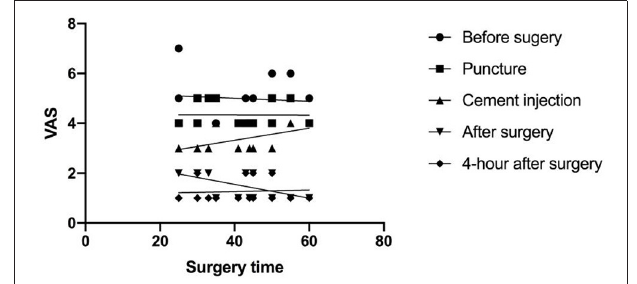
FIGURE 1 | The correlation of the visual analog scale (VAS) and the surgery time.